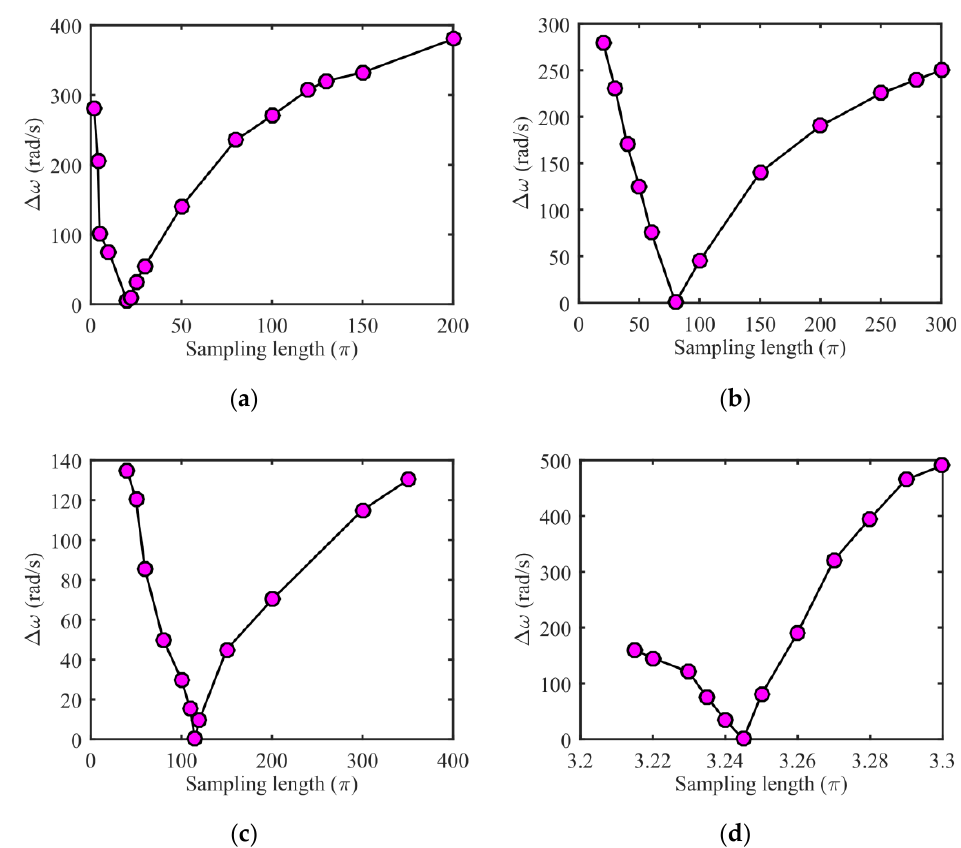
Figure 9. Relationships between the sampling lengths and the relatively errors of bifurcation points for the POMs with 3-DOFs at 4 different sampled rotational speeds: ( a ) 350 rad/s, ( b ) 500 rad/s, ( c ) 700 rad/s, ( d ) 1000 rad/s.